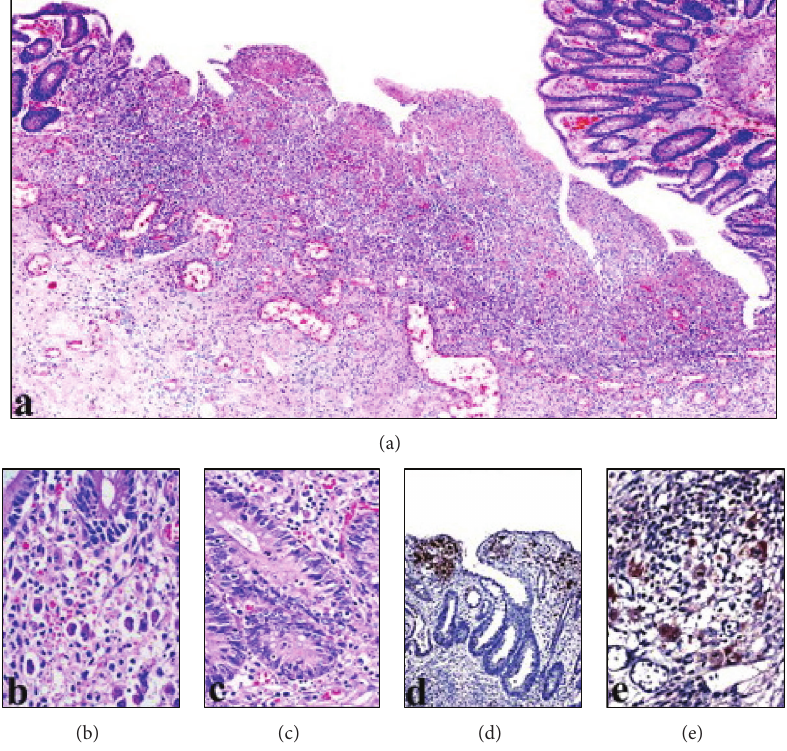
Figure2:Thisimageshowsmucosalulcerarea(a)withthecellscontainingviralinclusions(b),apoptosiswithincryptsandPMNLinfiltration (c), and immunohistochemical positivity of CMV (d and e) (magnifications (a) × 50; (b, c, and e) × 400; (d) ×